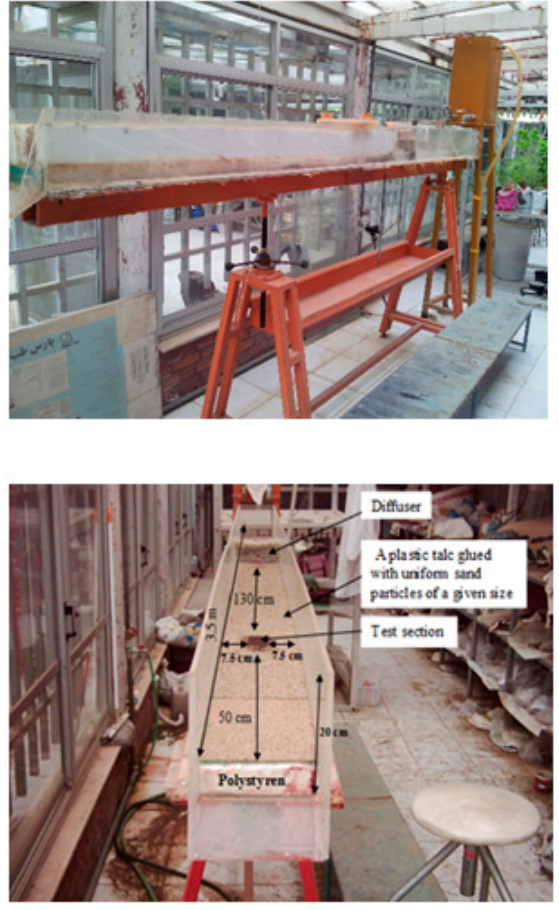
Figure 2. The experimental flume used to measure the rill detachment capacity under four land uses in the Saravan watershed (Northern Iran) [45,46].